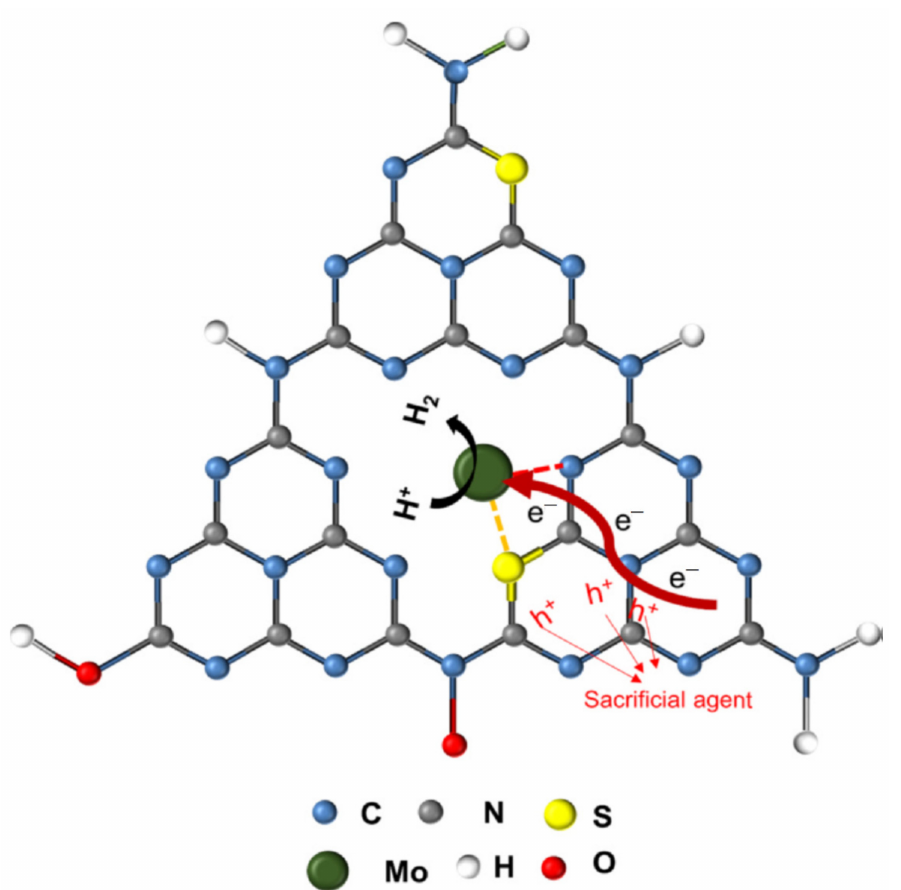
Figure 10. The proposed structure of Mo, S-GCN and the electron pathway for water splitting. Reproduced with permission from Ref.